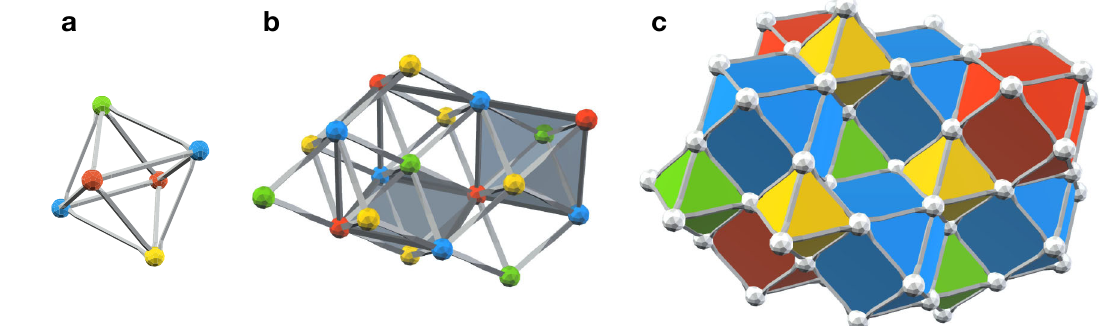
Fig. 4 | Colorable octahedral lattice examples. a An antipodally colored octa- hedron. b A colorable octahedral lattice L . We obtain L from the body-centered